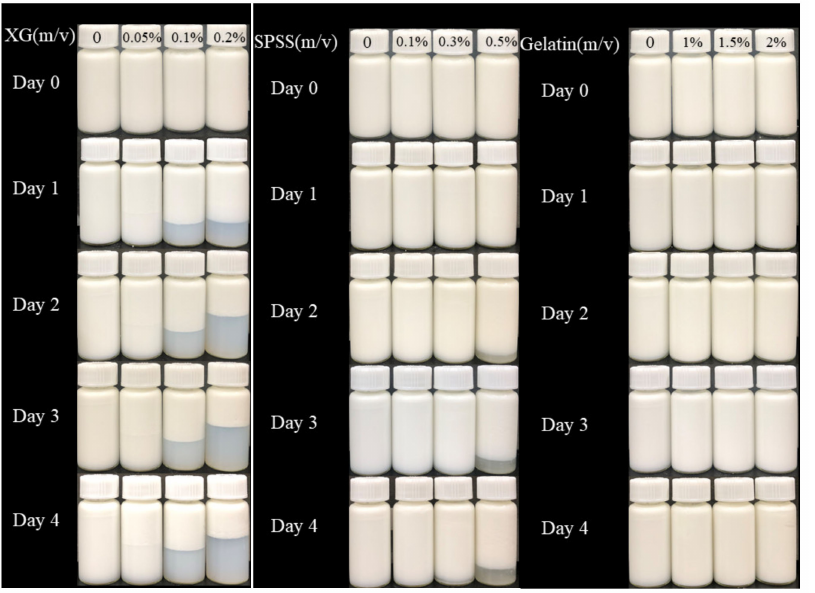
Figure 8. Visual observations of emulsion samples. (CP-Coconut protein, XG-Xanthan gum, SSPS- Soluble soybean